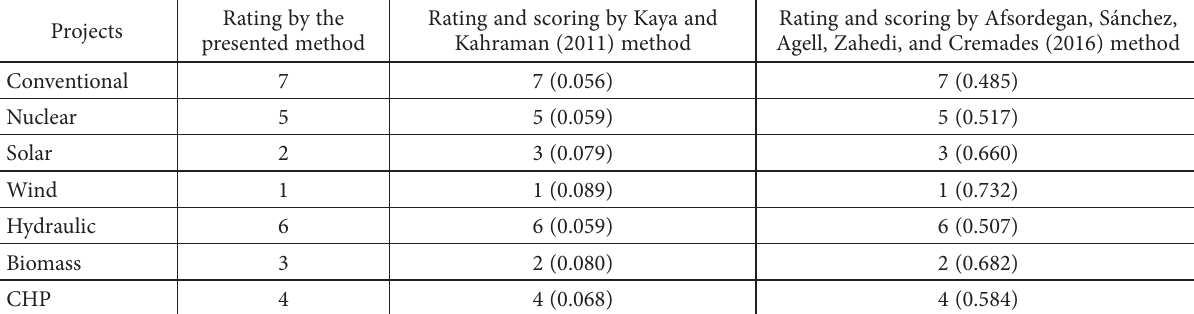
Table 8. Sensitivity analysis of three scenarios and comparing with Papapostolou et al. (2017) method Rating based on the proposed method Rating without Rating without computing Projects computing weights of computing weights of weights of criteria criteria DMs